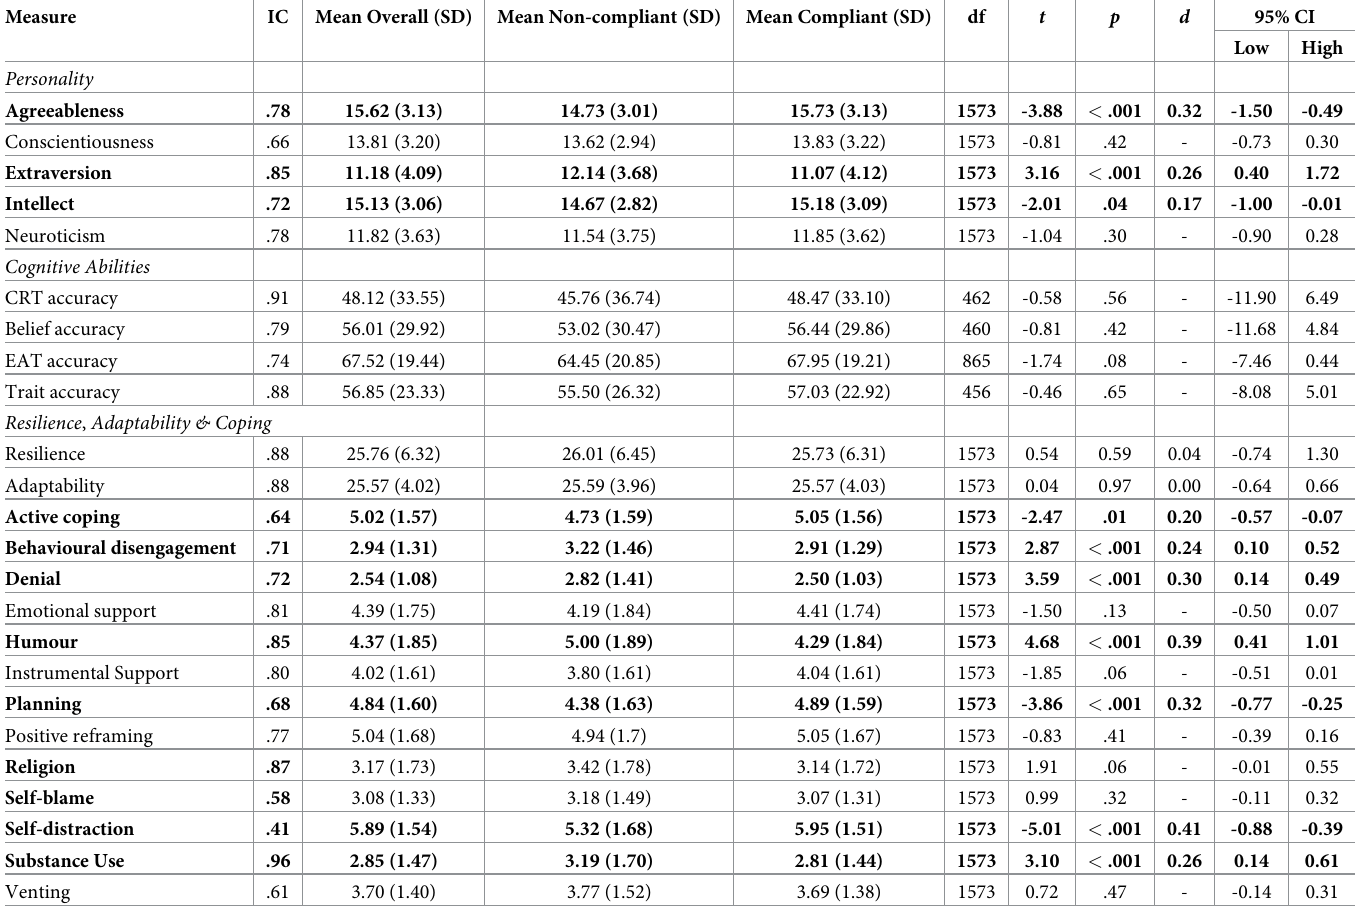
Table 5. Independent samples t-tests on the difference between classes on psychological